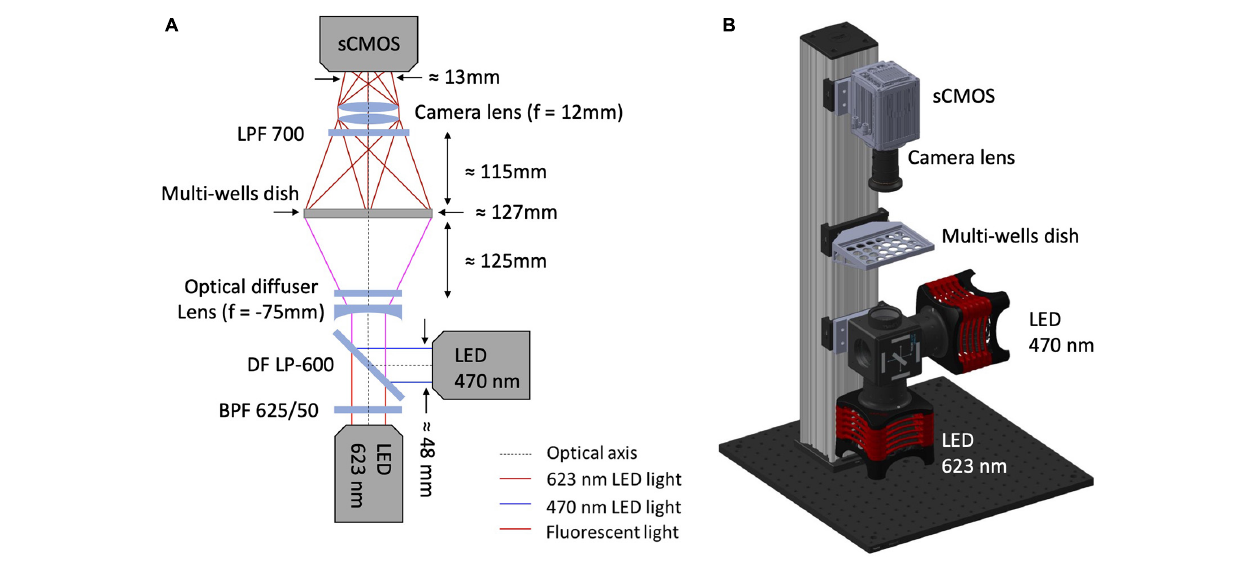
FIGURE 1 | MULTIPLE optomechanical system design. (A) Optical scheme of MULTIPLE platform. The excitation system combines a red LED followed by a band-pass filter (625/50 nm) with a blue LED using a large-area dichroic beam mounted on a kinematic fluorescence cube (DFM2/M, Thorlabs). A divergent lens combined with an optical diffuser is used to homogenize the light intensity irradiating the multiwell plate. The fluorescence signal is filtered with a long-pass filter and focused into a sCMOS camera sensor through a camera lens. (B) 3D mechanical scheme of MULTIPLE characterized by a final footprint of 450 × 450 × 900 mm. The illumination, detection and sample holder blocks are vertically aligned on a construction rail through drop on rail carriages.